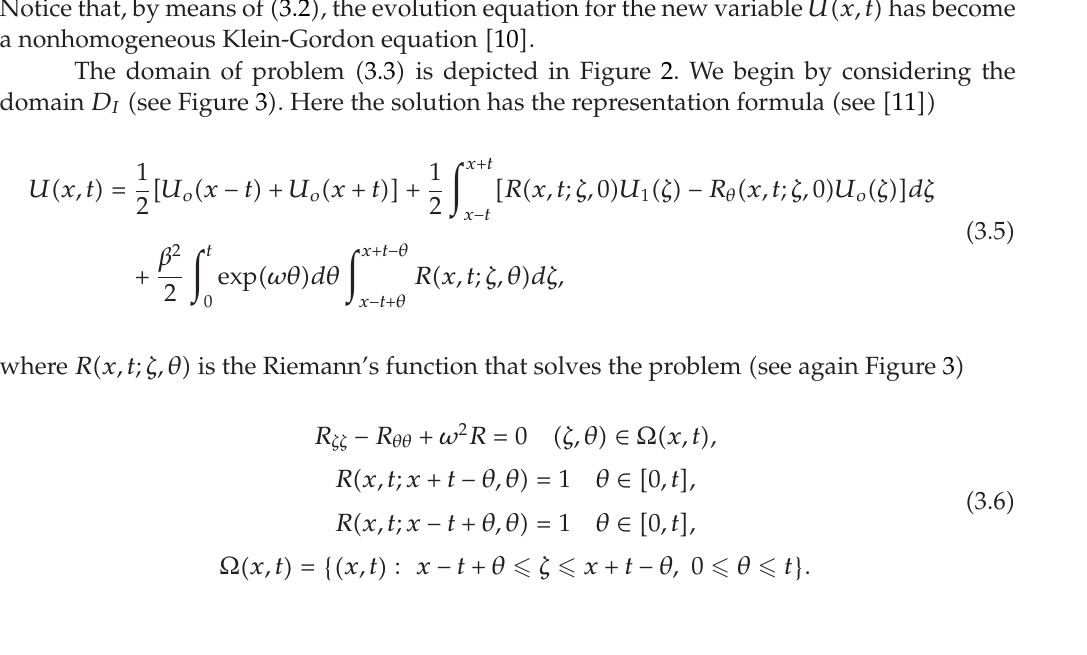
Figure 3: The domain D I